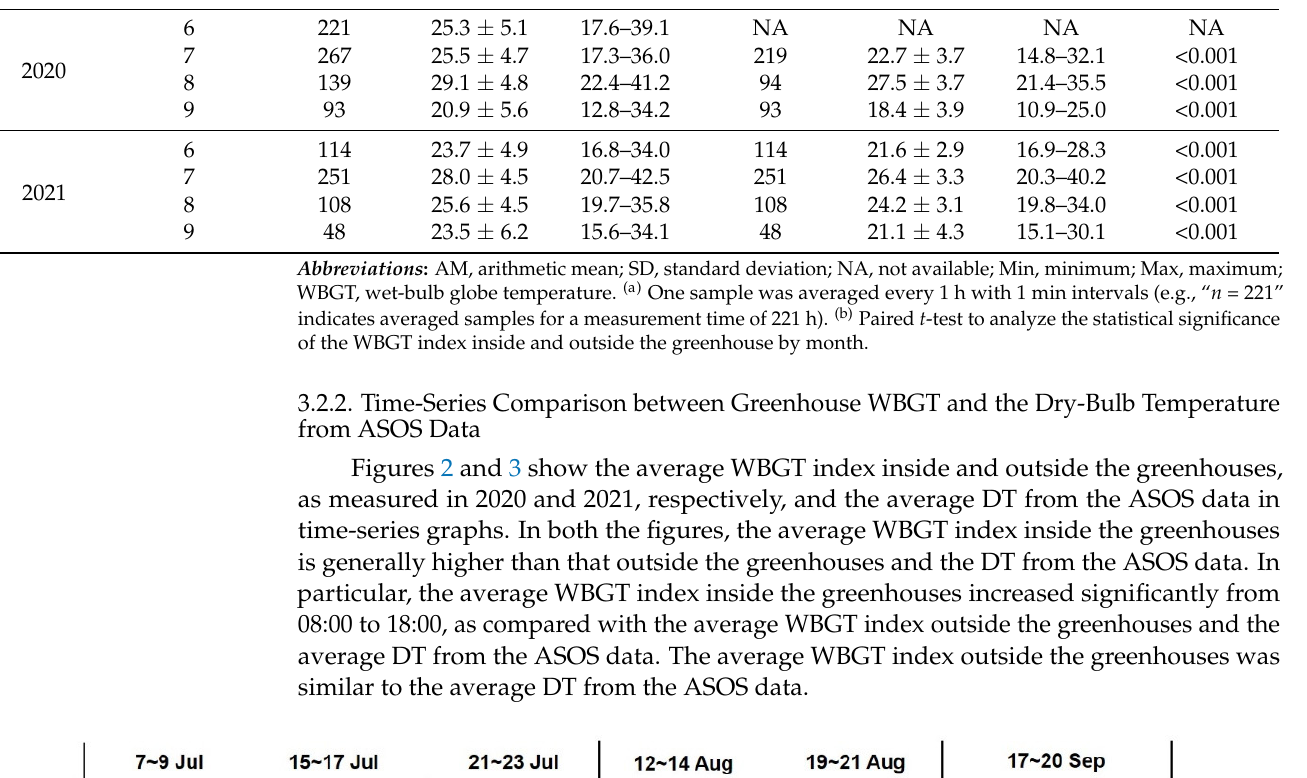
Figure 3. Time-series graphs of the wet-bulb globe temperature (WBGT) index inside and outside greenhouses and of the dry-bulb temperature from Automated Synoptic Observing Systems (ASOS) data for 2021. 3.3. Greenhouse WBGT Levels by Time Period Figure 4 shows the average indoor WBGT index data from June to September at 1 h intervals for a day. The highest average WBGT index values between 12:00 and 13:00 were 33.1 ± 4.7 and 32.7 ± 3.8 °C for 2020 and 2021, respectively. In addition, the maximum WBGT index during this time period reached 41.2 and 42.5 °C in 2020 and 2021, respec- tively. The time periods with an average WBGT index of 30 °C or higher were 11:00 to 17:00 in 2020 and 09:00 to 17:00 in 2021. For domestic agricultural work characterized as moderate work, the reference limits provided by the heat stress standard ISO 7243 for workers acclimatized to heat and those not acclimatized to it were considered. When 28 °C was considered as the reference limit of heat-acclimatized workers, this limit was ex- ceeded from 09:00 to 18:00 in 2020 and from 08:00 to 18:00 in 2021. For the assumption that